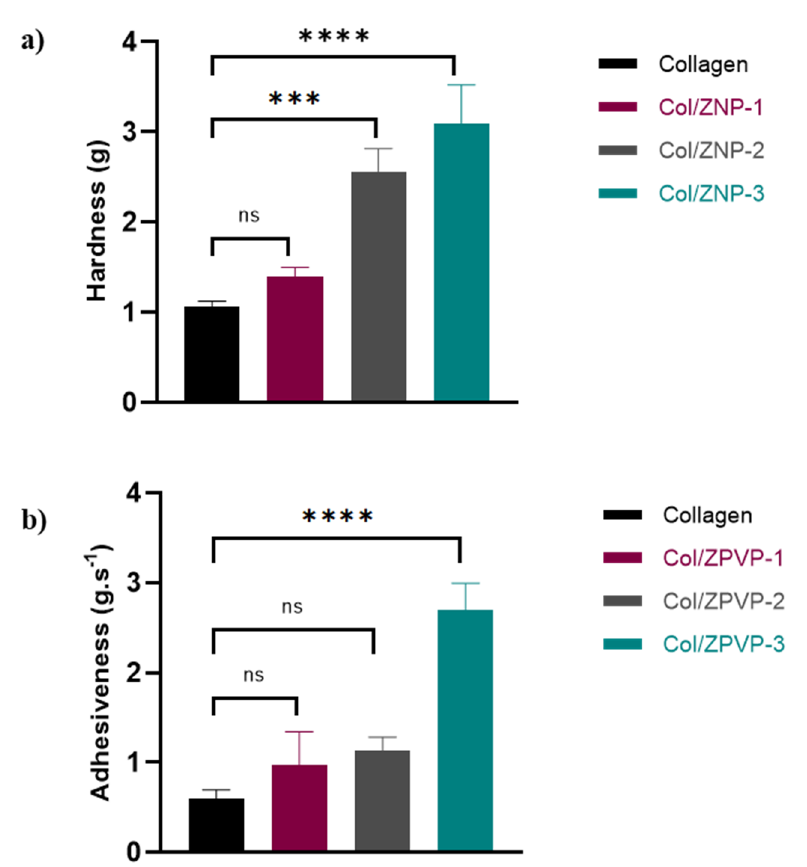
Figure 2. ( a ) Hardness and ( b ) adhesiveness of plain collagen, Col/ZPVP-1, Col/ZPVP-2, and Col/ZPVP-3 hydrogels at room temperature. Error bars represent the standard deviation (SD); n = 3; ns = non-significant ( p > 0.05); *** p ≤ 0.001; **** p ≤ 0.0001.